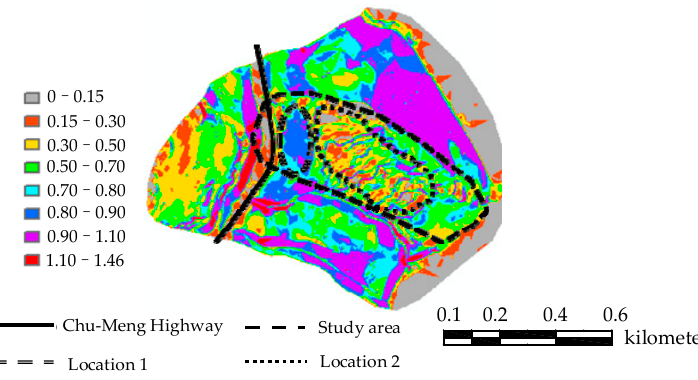
Figure 11. Slope unit flow diagram (unit: m 3 /d ).